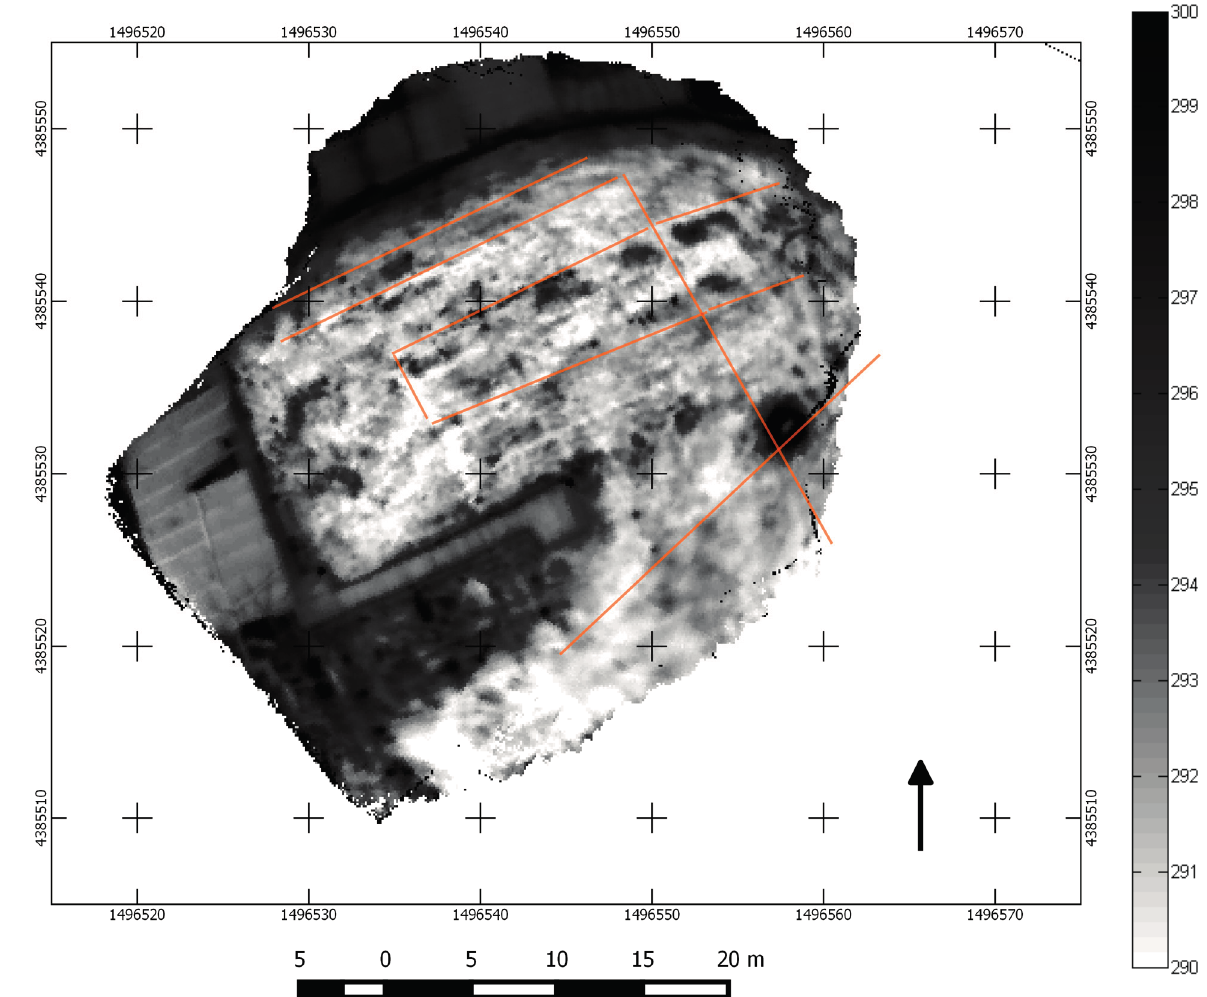
Figure 13. The apparent intercept temperature map, in Kelvin, in a stretched grayscale image shows correspondences with previous building alignments (see Figure 11a) in the northern